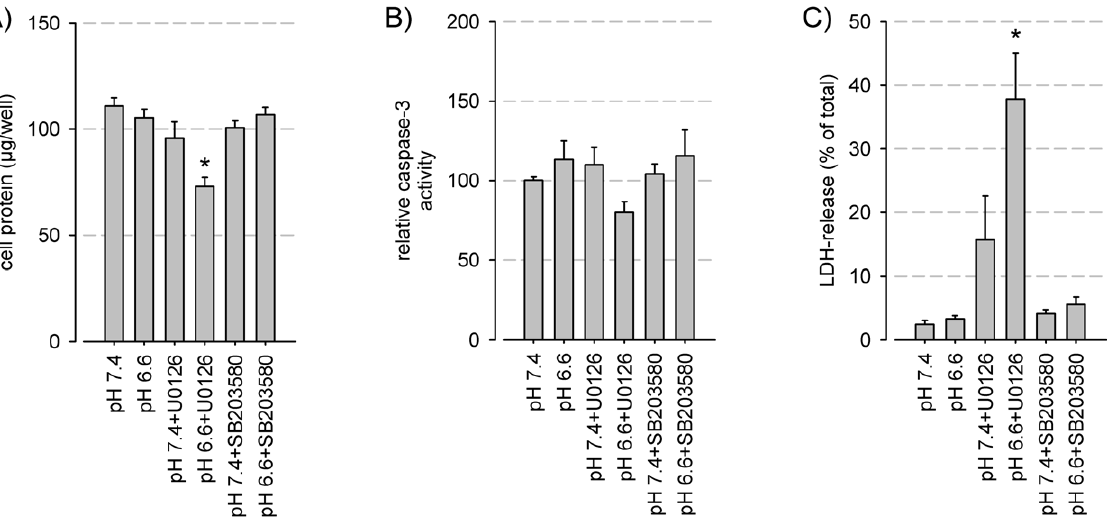
Figure 3. Impact of acidosis and MAPK-inhibitors on cell viability. (A) Cell protein content, (B) caspase-3-activity (apoptosis) and (C) LDH- release (necrosis) of AT1 cells after 3 h incubating at different pH with or without inhibitors of the ERK1/2 (U0126) or p38 (SB203580) pathway (N=12–18); (*) p , 0.05.